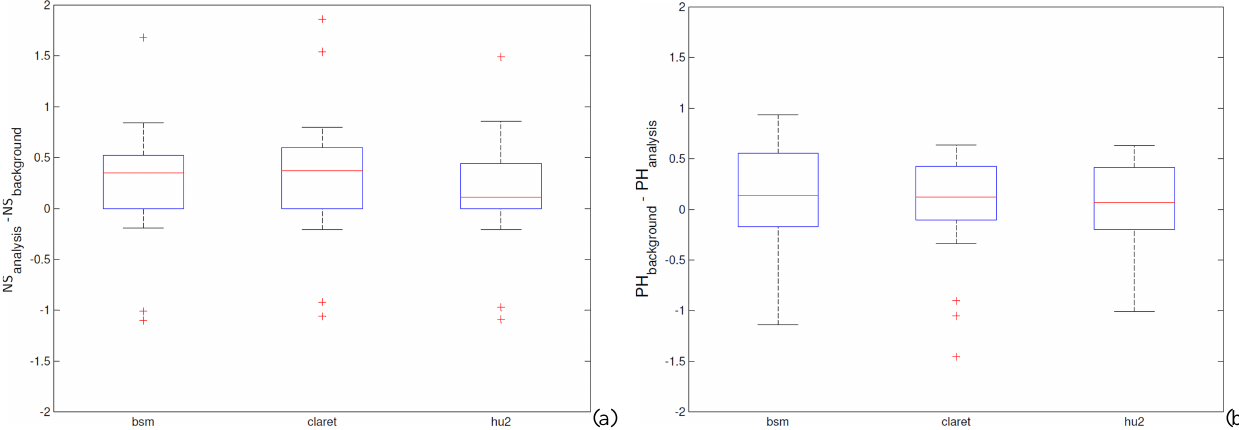
Fig. 14. Box plots of simulation performance: (a) NS analysis − NS background ; (b) PH background − PH analysis . The simulations shown are: bsm ( S = S Bois Saint Mathieu ; β =250m 6 s − 2 ), claret ( S = S Claret ; β =250m 6 s − 2 ), and hu2 ( S = S Hu2 ; β =250m 6 s − 2 ).